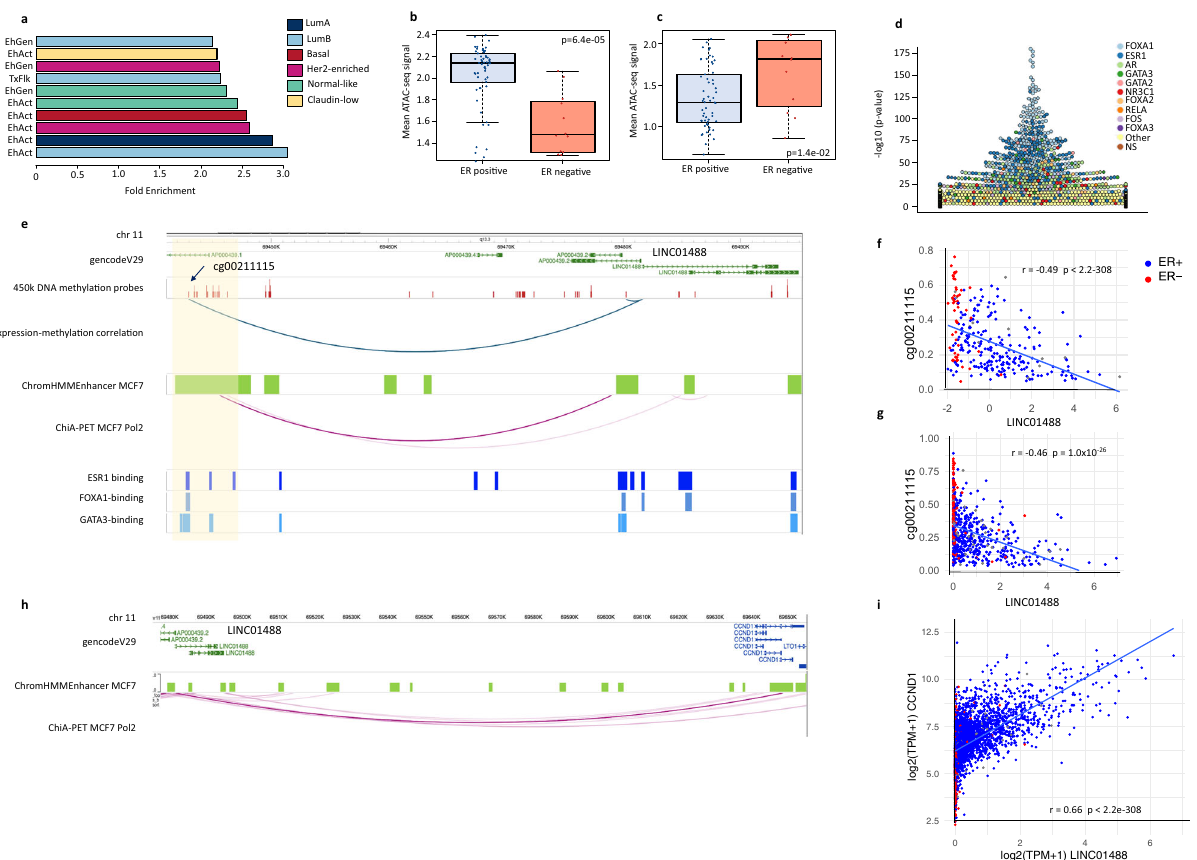
Fig. 5 Distal regulatory element in the LINC01488 locus. a Enrichment of CpGs with DNA methylation signi fi cantly inversely correlated with lncRNA expression across ChromHMM genome segmentation from breast cancer cell lines. Enrichment is calculated by comparing the genomic location of the CpG inversely correlated to all the CpGs on the 450k Illumina array as background. Active Enhancer = EhAct, Ehnancer Genic = EhGen, Transcription fl anking = TxFlk. Average normalized counts for ATAC-seq peaks mapped to CpG location for which DNA methylation is signi fi cantly inversely correlated with lncRNAs with higher expression in ER positive cases ( b ) and higher expression in ER negative cases ( c ). ATAC-seq data from ER + (blue dots) ( n = 58) and ER- (red dots) ( n = 12) breast tumor samples from the TCGA-BRCA cohort. Wilcoxon test p -values are denoted. The line within each box represents the median. Upper and lower edges of each box represent 75th and 25th percentile, respectively. The whiskers represent the lowest datum still within [1.5 × (75th − 25th percentile)] of the lower quartile, and the highest datum still within [1.5 × (75th − 25th percentile)] of the upper quartile. d Swarm plot showing enrichment of TF binding sites ( – (log10( p -value) using Fisher ’ s exact tests) on the y-axis for CpGs with DNA methylation inversely correlated with lncRNA expression. Names of the top 10 enriched TF binding sites data sets are annotated by colours. e Graphical illustration of the LINC01488 locus annotated for different epigenomic tracks. CpGs measured by the 450 k Illumina array are shown together with the signi fi cant negative correlations between levels of DNA methylation and LINC01488 expression in the OSLO2 and TCGA cohorts (blue arcs, negative expression-methylation correlation). ChromHMM Enhancer regions (active and genic) in the Mcf7 cell line (green) with ChiA-PET polII loop connecting the TSS of LINC01488 to the CpG in the enhancer region (pink arcs). TF binding of ESR1 (dark blue), FOXA1 (blue), and GATA3 (light blue) from ChIP-seq experiments (ReMap). f , g Correlation plot of levels of LINC01488 expression (x-axis) and levels of DNA methylation of the CpG (y-axis) in long-range interaction in e . Rho and p - value from Spearman correlation is indicated. f OSLO2 (ER positive, n = 214, ER negative, n = 52), g TCGA (ER positive, n = 807, ER negative, n = 237. h Graphical illustration of the LINC01488 locus annotated with ChromHMM Enhancer regions (active and genic) in the Mcf7 cell line (green) and ChiA-PET polII loop connecting LINC01488 to CCND1 (pink arcs). i Correlation plot of log2(TPM + 1) LINC01488 expression (x-axis) and log2(TPM + 1) CCND1 expression (y-axis) in ER positive ( n = 2409) and ER negative ( n = 504) patients in the SCAN-B cohort. Rho and p -value from Spearman correlation are